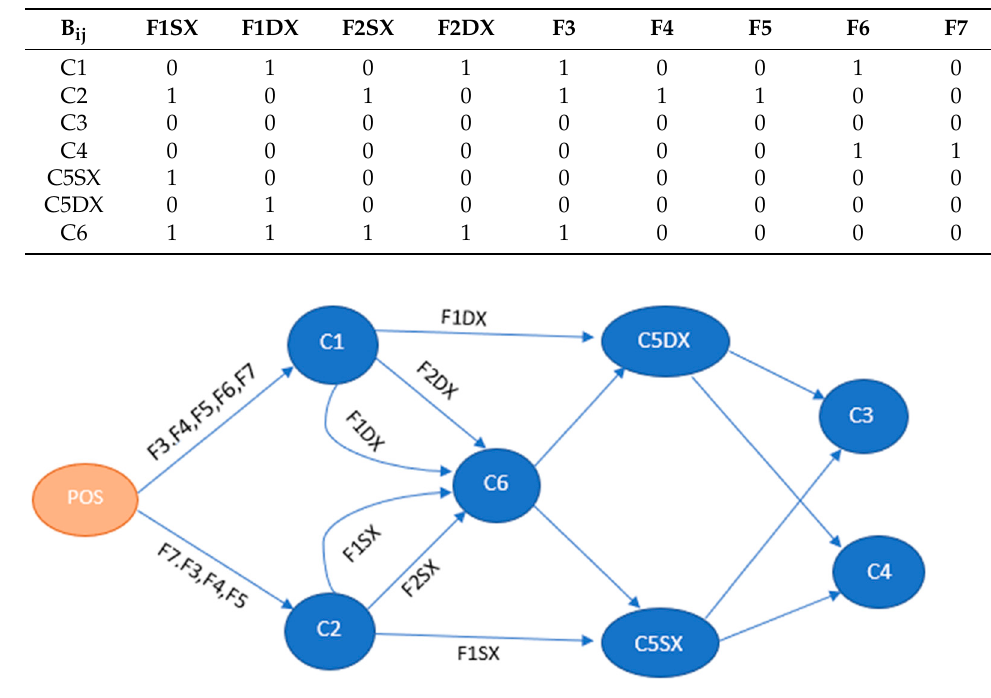
Figure 9. Oriented graph.